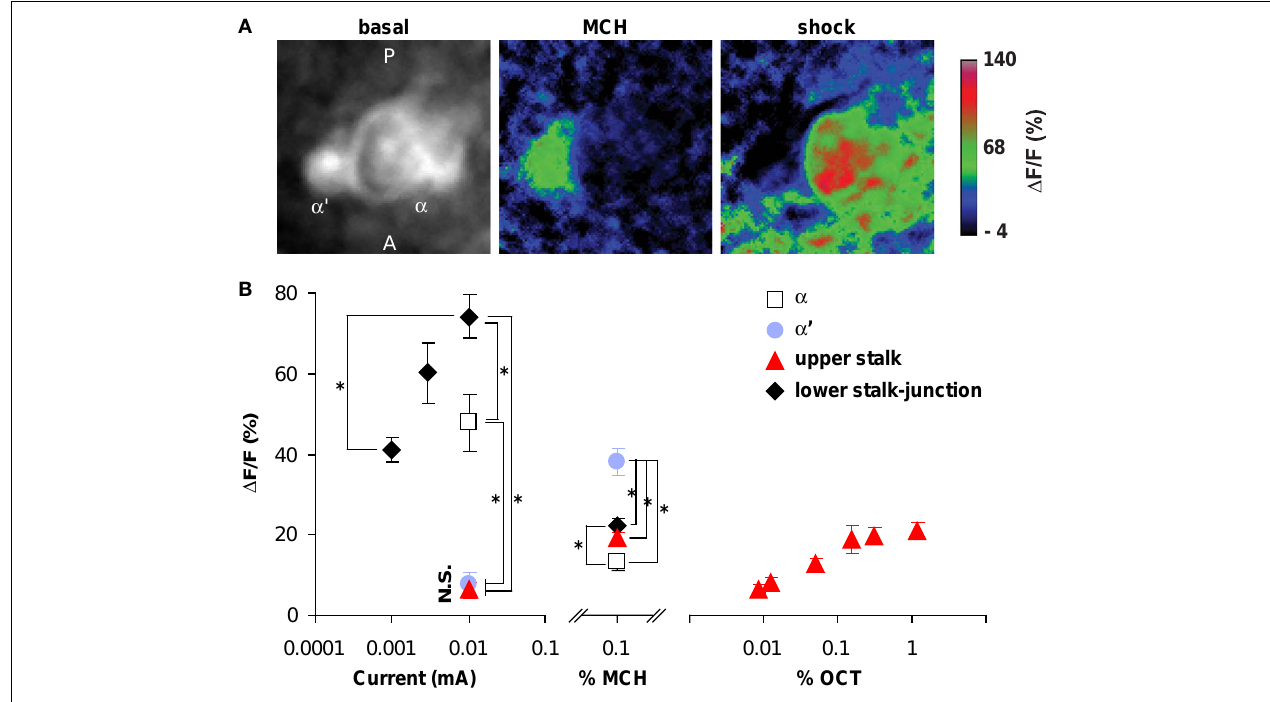
FIGURE 7 | Odor and shock response properties of dopaminergic processes in four subareas of the mushroom body lobes. (A) General response properties shown from one TH-GAL4>UAS-G-CaMP fl y. Left, basal fl uorescence. Middle, response to 0.1% methylcyclohexnol (MCH) presented to the antennae of the fl y. Right, Response to 0.01 mA electric shock presented to the legs. All three images are averages of fi ve successive frames either before (basal) or at the peak responses (MCH and shock). The tips of α lobe and α′ lobe were imaged simultaneously. MCH elicits a robust response in the PPL1 neuron processes that innervate the α′ tip and a much more modest response in those that innervate the (cid:2) α tip. Electric shock elicited a robust response in the processes that innervate the α tip and a much more modest response in those that innervate the α′ tip. PPL1 neurons therefore exhibit differential response